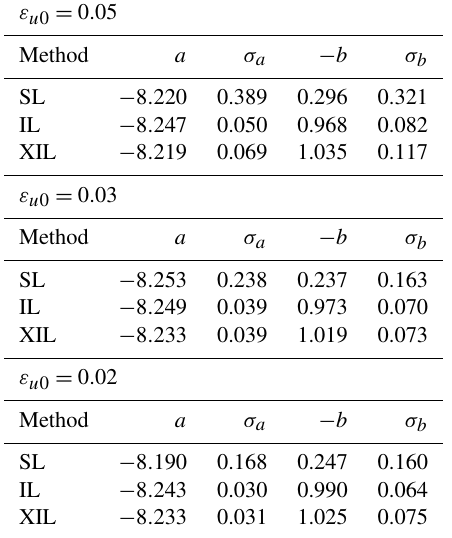
Table 4. Estimates of a and b values at λ = 500nm and their RMSD values ( σ a , σ b ) in the F 0 retrieval by IL and XIL methods for ILP data at the Tokyo University of Science (TUS) site for 4 months from February through May 2017. Results of three screening con- ditions of Eq. (17) with ε u 0 = 0 . 05, 0.03, and 0.02 are listed. ε u 0 = 0 .